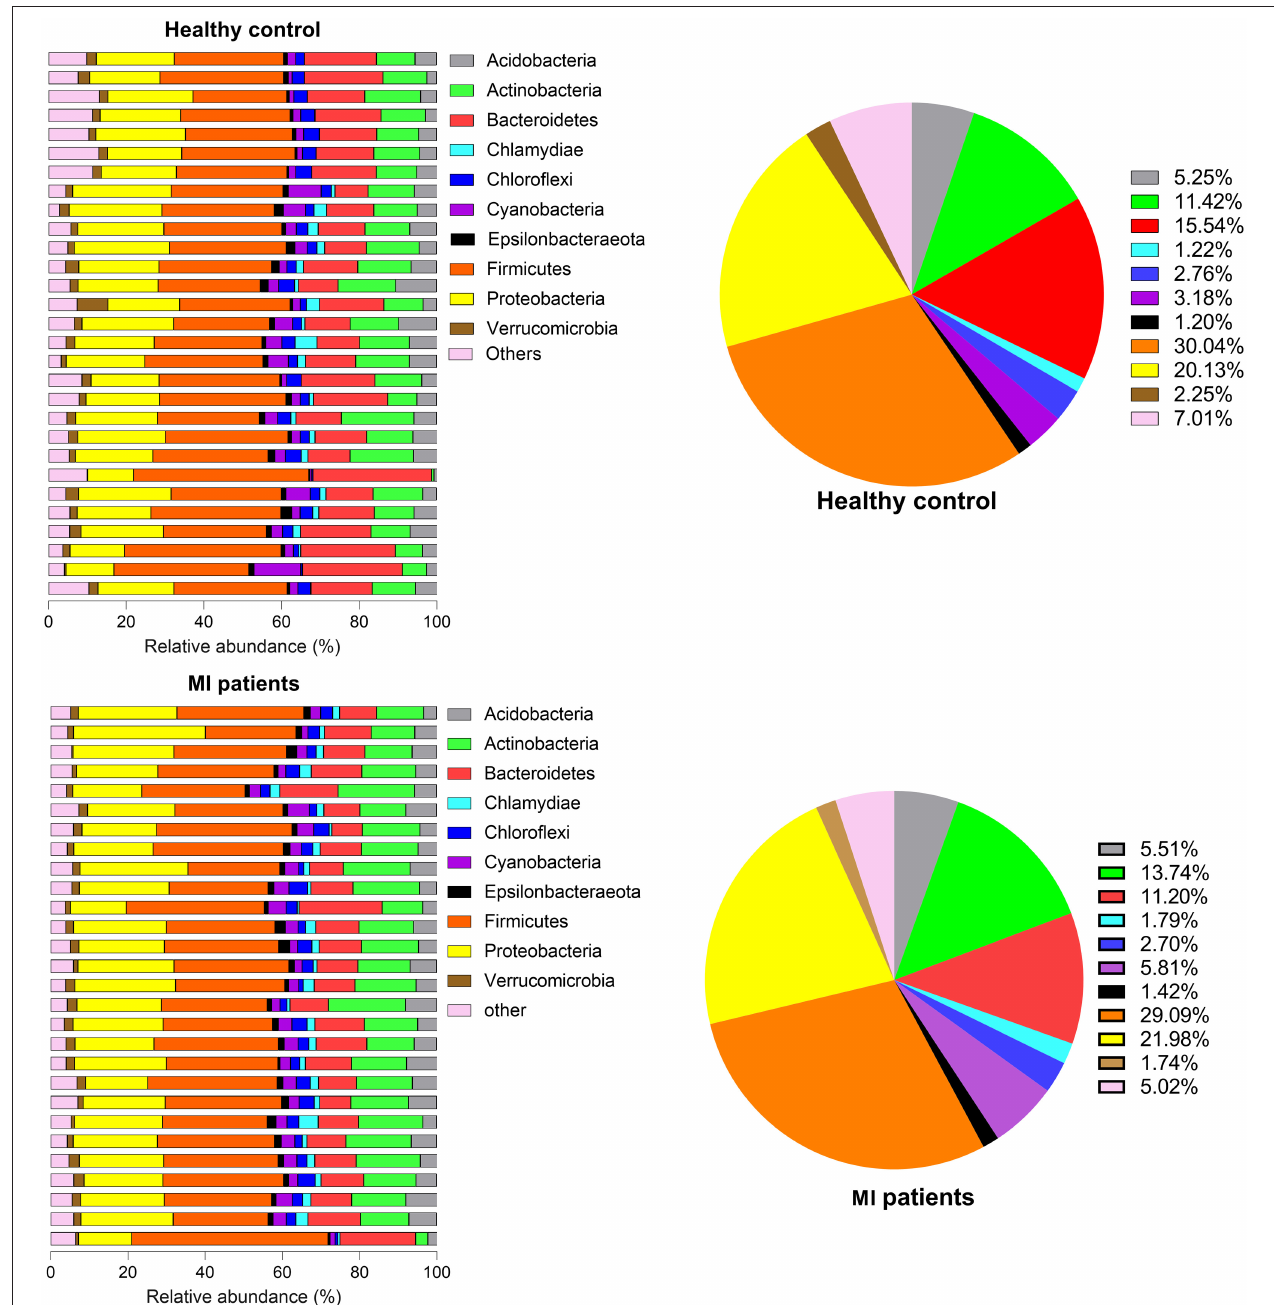
FIGURE 2 | Phylum proportion of HC and MI groups. Pie charts indicate the percentages of each of the top 10 high-abundance phyla in both groups.